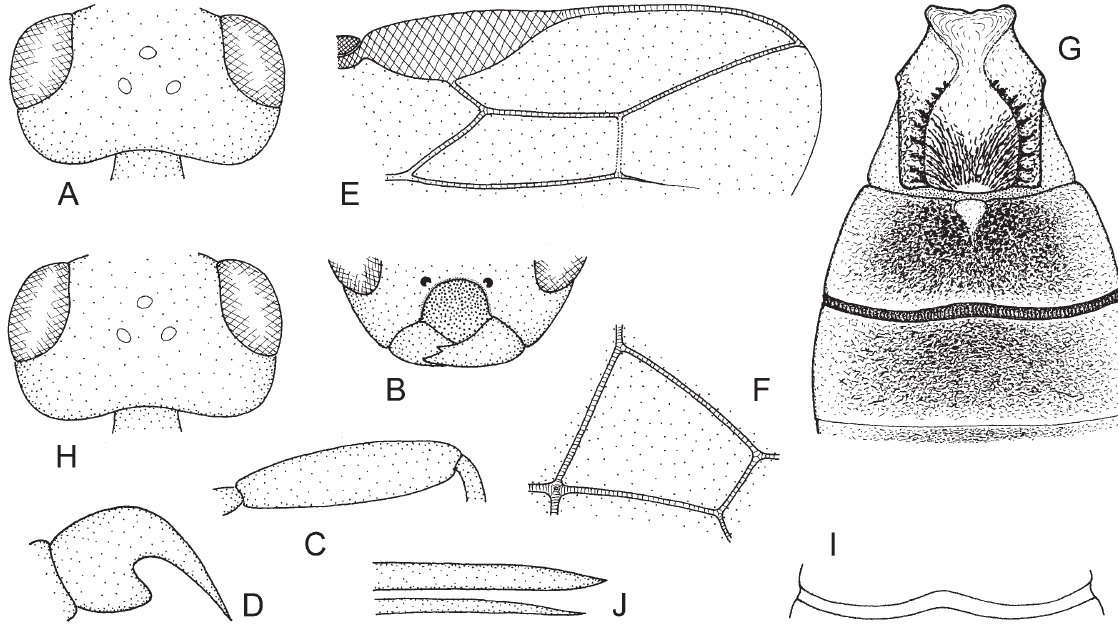
Fig. 45. Bracon ( Bracon ) scutellaris Wesmael, 1838 (A-G: ♀ lectotype, H-J: ♀ paralectotype). A . Head in dorsal view. B . Head in frontal view. C . Hind femur. D . Claw. E . Distal part of right forewing. F . First discal cell of right forewing. G . Tergites 1-3. H . Head in dorsal view. I . Suture between tergites 2-3. J . Posterior end of ovipositor